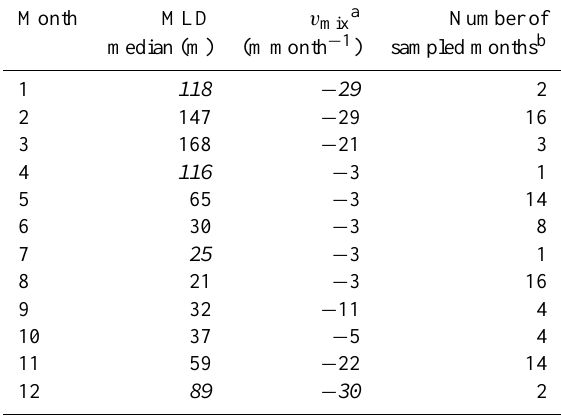
Table 1. Monthly computed median mixed layer depths (MLDs) and entrainment velocities ( v mix ) . These are used when calculating the vertical fluxes. The values in italic are interpolated from sur- rounding monthly data. See text for details.